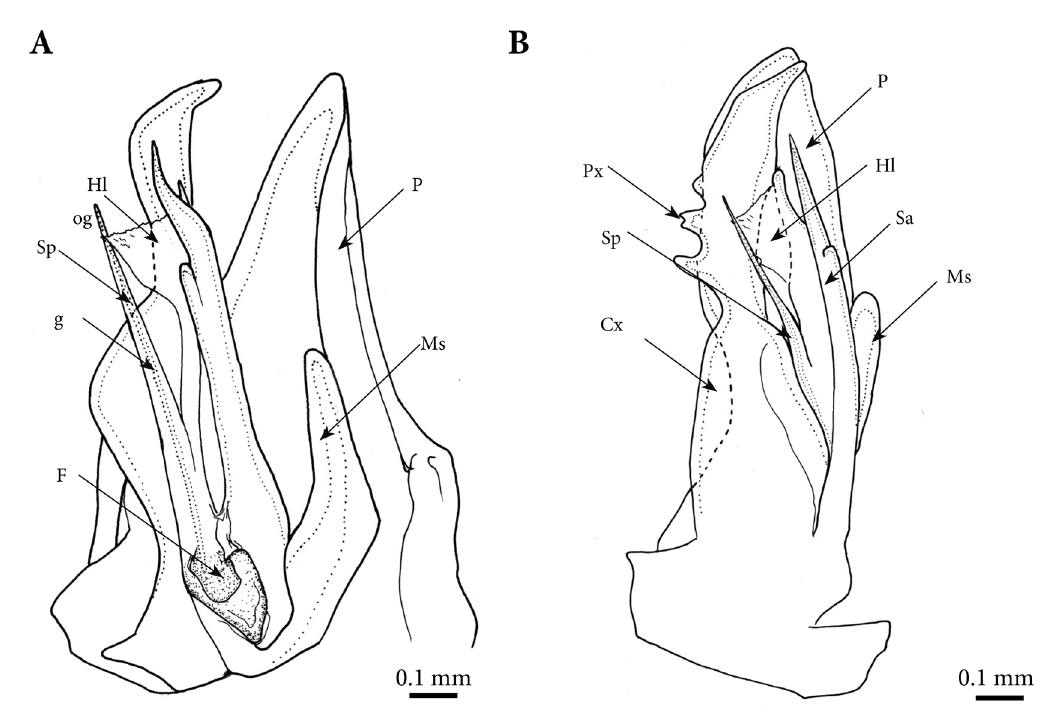
Fig. 10. Ommatoiulus denticulatus sp. nov. Holotype ♂. A . Right gonopod, mesal view B . Right gonopod, posterior